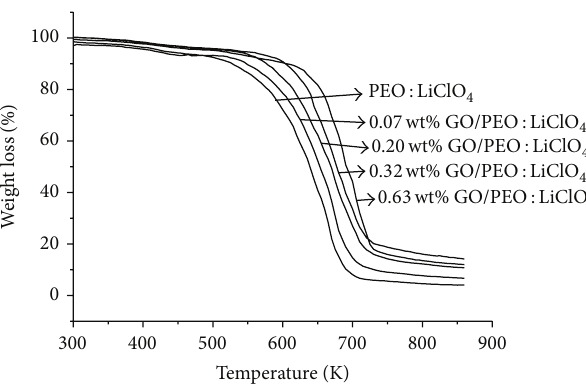
Figure 5: TGA of PEO:LiClO 4 and also with different GO concen-